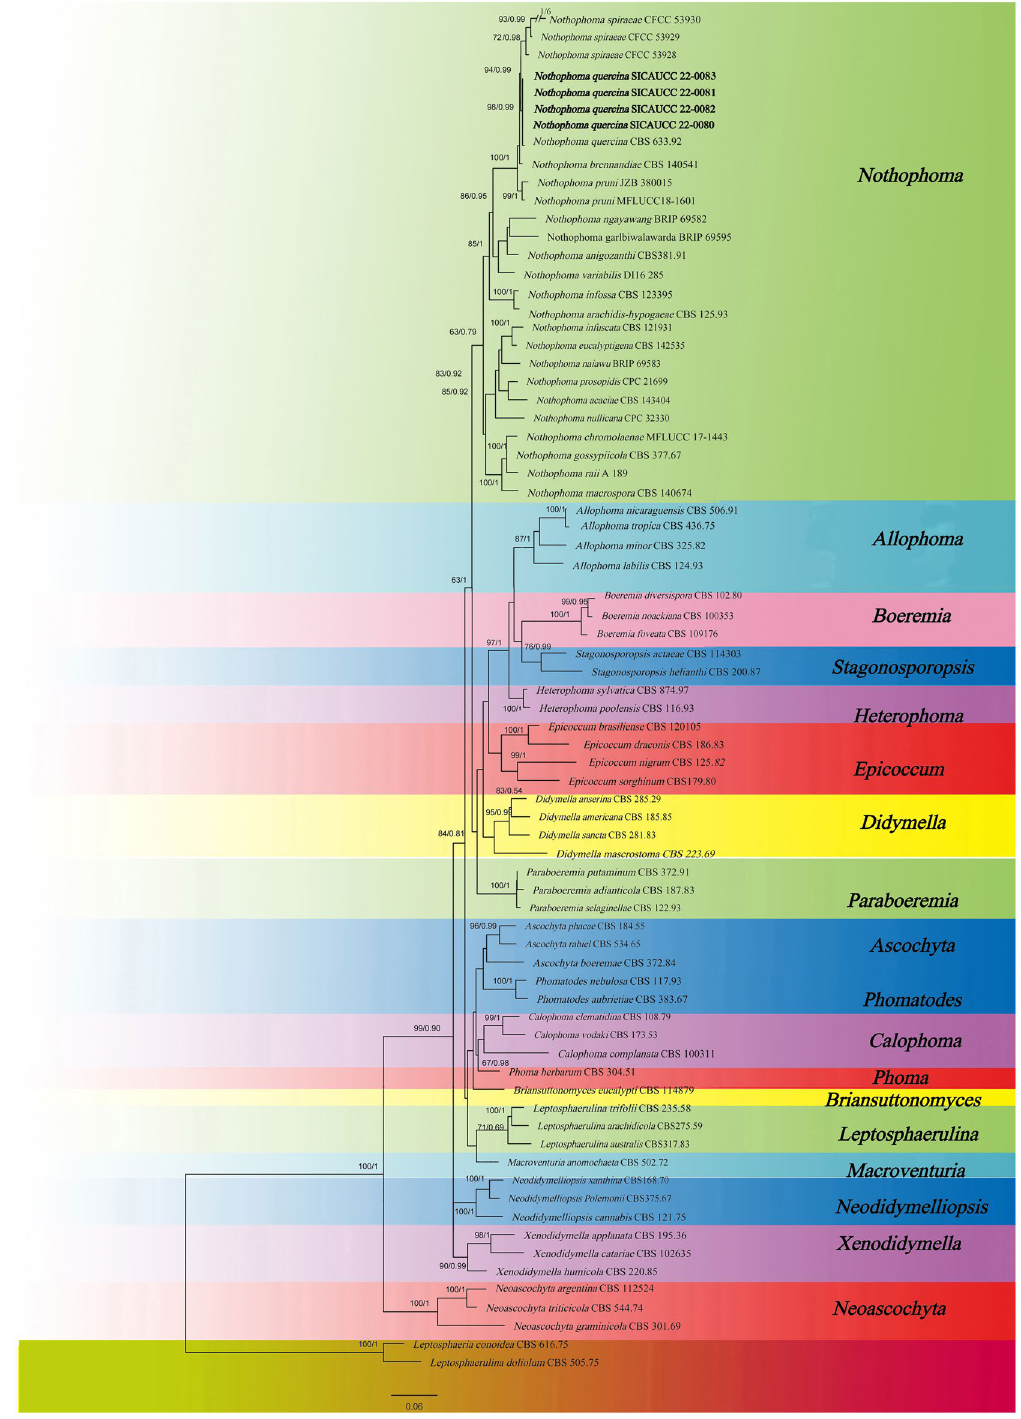
Figure 3. RAxML tree based on a combined dataset of a partial LSU, ITS, tub 2 and rpb 2 sequence analysis in Didymellaceae. The tree is rooted with Leptosphaeria conoidea (CBS 616.75) and L. doliolum (CBS 505.75). ML and Bayesian posterior probabilities values are given at the nodes. The new isolate is highlighted in